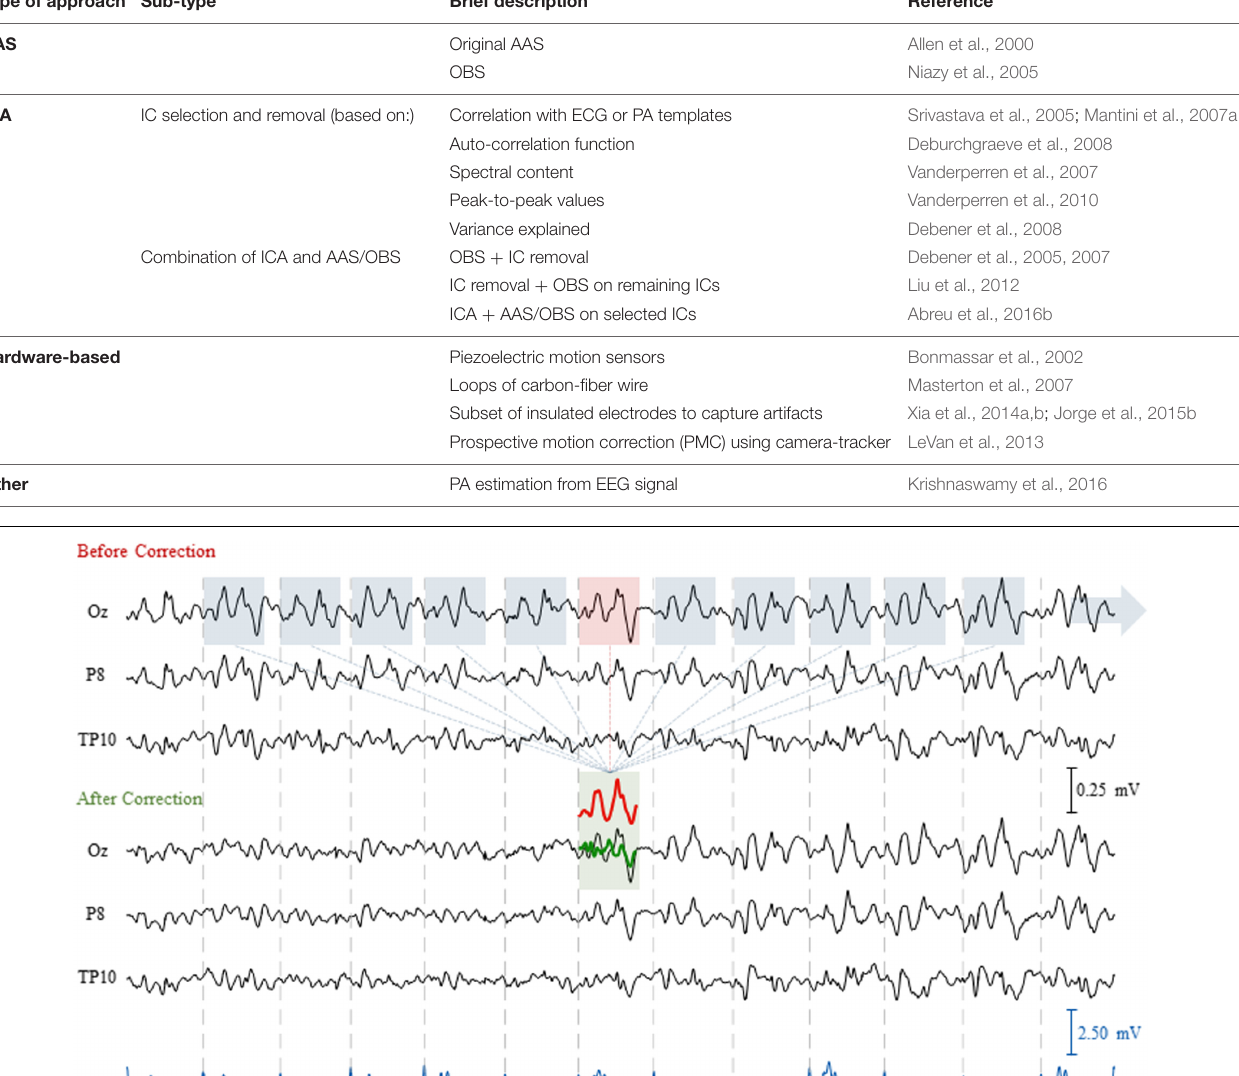
TABLE 2 | List of PA correction methods. These methods can be roughly divided into four main approaches: AAS-based (AAS and OBS), ICA-based (with selection and removal of PA-related ICs or combination with AAS/OBS), hardware-based and others. Type of approach Sub-type